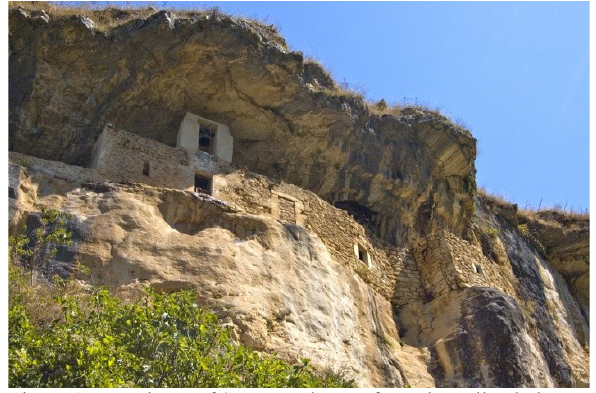
Figure 1. Hermitage of San Bartolomeo from the valley